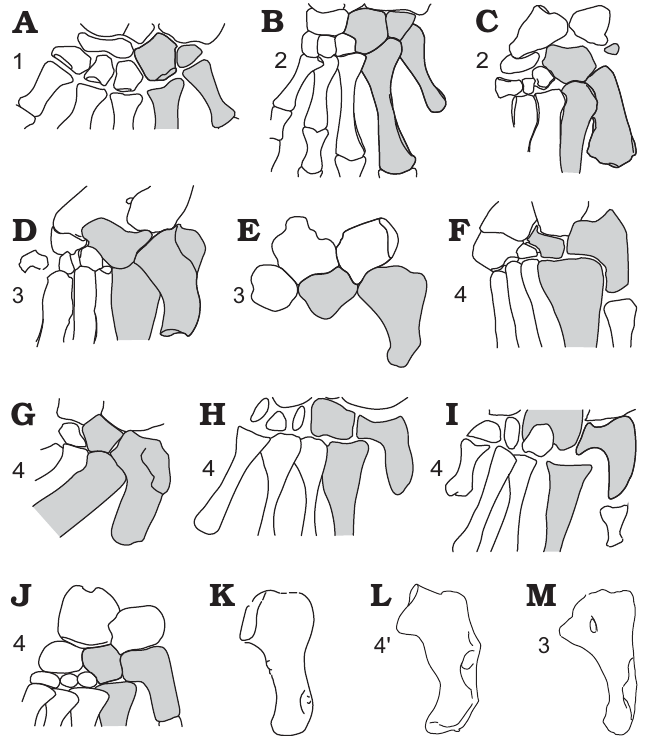
Fig. 8. Schematic relations between distal tarsals and metatarsals in diap- sids and their out-group. A . Captorhinus , basal Amniota, Early Permian, North America (after Heaton and Reisz 1982). B . Petro lacosaurus , basal Diapsida, Late Carboniferous, North America (after Reisz